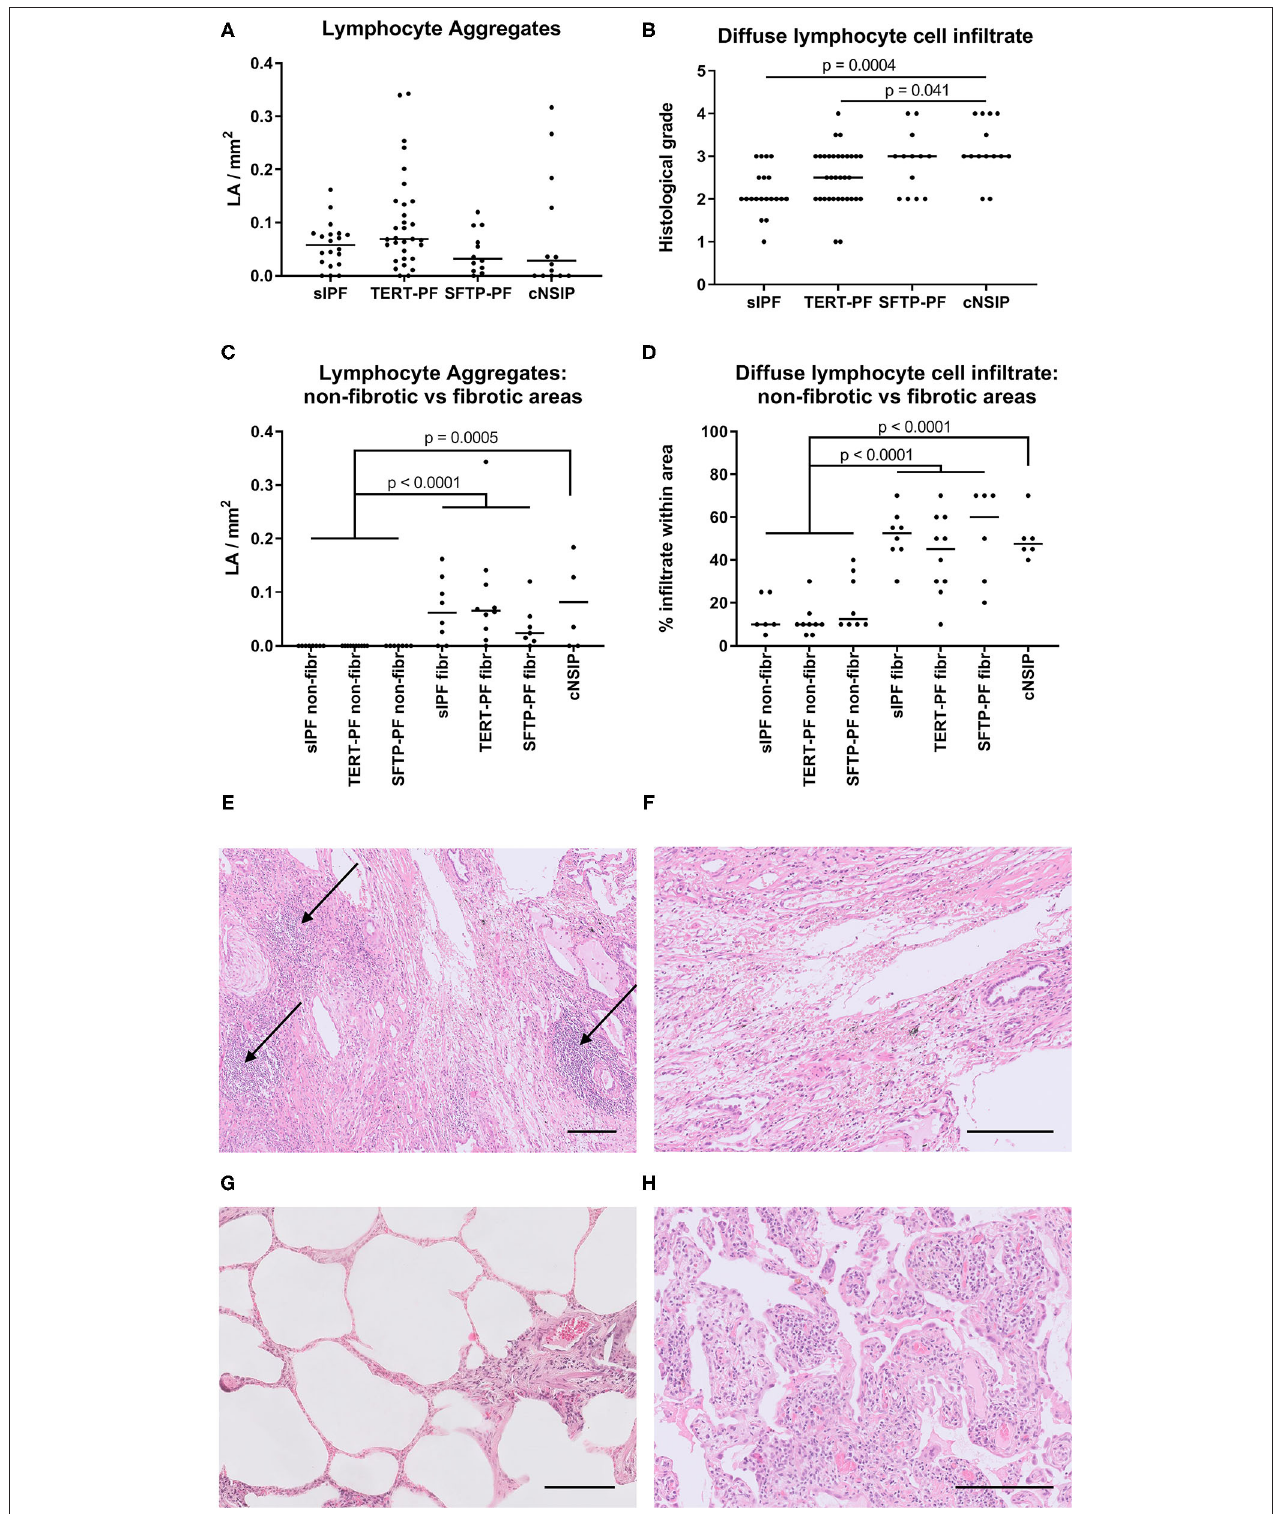
FIGURE 2 | Quantification of lymphocyte aggregates and diffuse lymphocyte cell infiltrate. Scatter plots of lymphocyte aggregates (arrows in Figures 1B , 2E ) and diffuse lymphocyte cell infiltrate in diagnostic biopsies of 17 TERT-PF, 7 SFTP-PF, 10 sIPF, and 10 cNSIP lungs analyzed (A,B) throughout the biopsy and in (C,D) 5 randomly selected biopsies per group to specifically assess non-fibrotic and fibrotic areas. In whole lung specimens, no significant differences were found between TERT-PF and SFTP-PF groups. In cNSIP lungs, the degree of diffuse lymphocyte cell infiltrate was significantly higher than in sIPF ( p = 0.0004) and TERT-PF